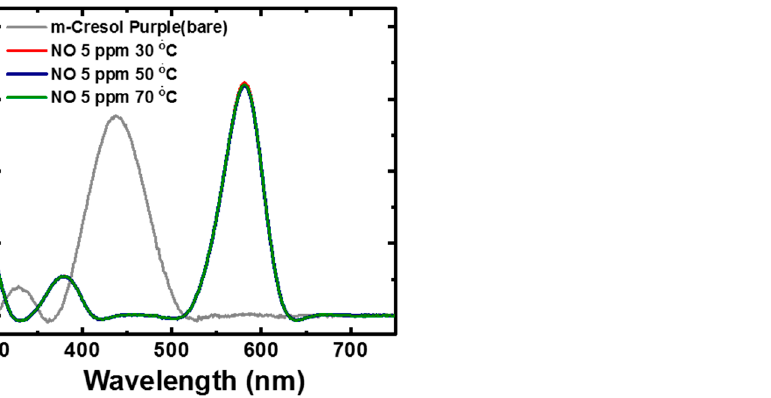
Figure 3. The UV–Vis absorbance plot of m-Cresol Purple dye after adding 5 ppm of NO at differ- ent temperatures.